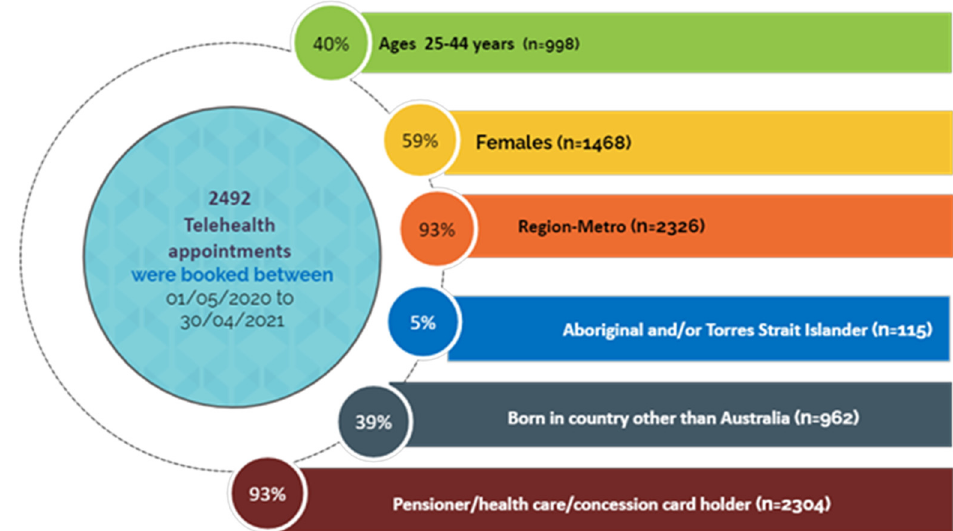
Figure 2. The number of Teledentistry appointments booked at RDHM between 1 May 2020 and 30 April 2021 ( n = 2492).